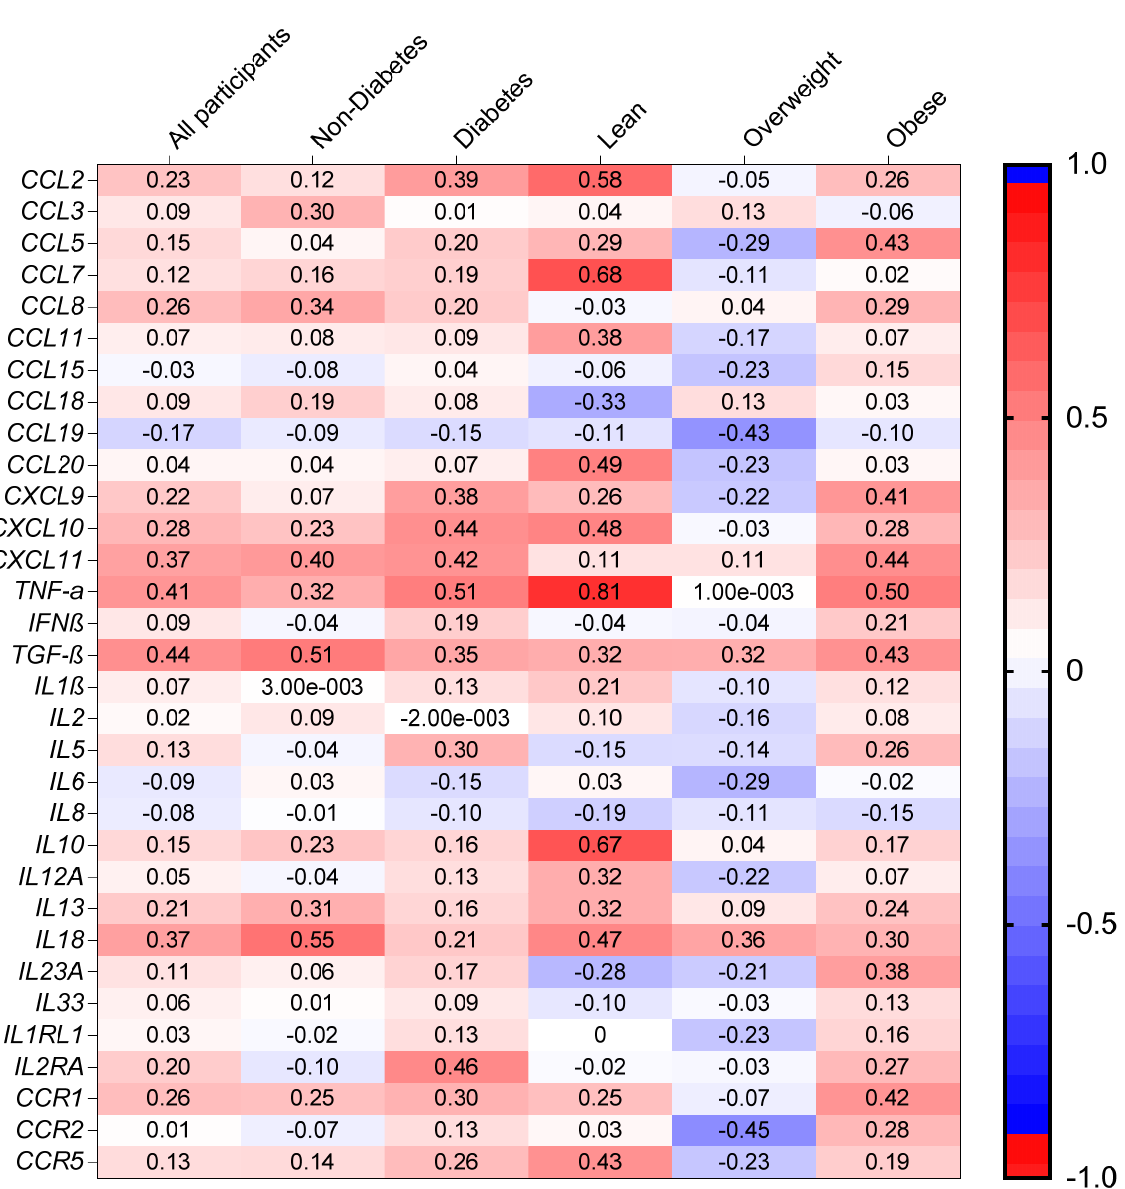
Figure 3. Heat map of the correlation of SRA1 expression with inflammatory markers in adipose tissue. We observed that inflammatory markers (TNF- α and IL-18) protein expression was positively correlated with SRA1 protein expression in individuals without diabetes (Supplementary Figure S2). We also observed inflammatory markers (IL-8, TNF- α and CCL2) protein expression was positively correlated with SRA1 protein expression in individuals with diabetes (Supplementary Figure S3).